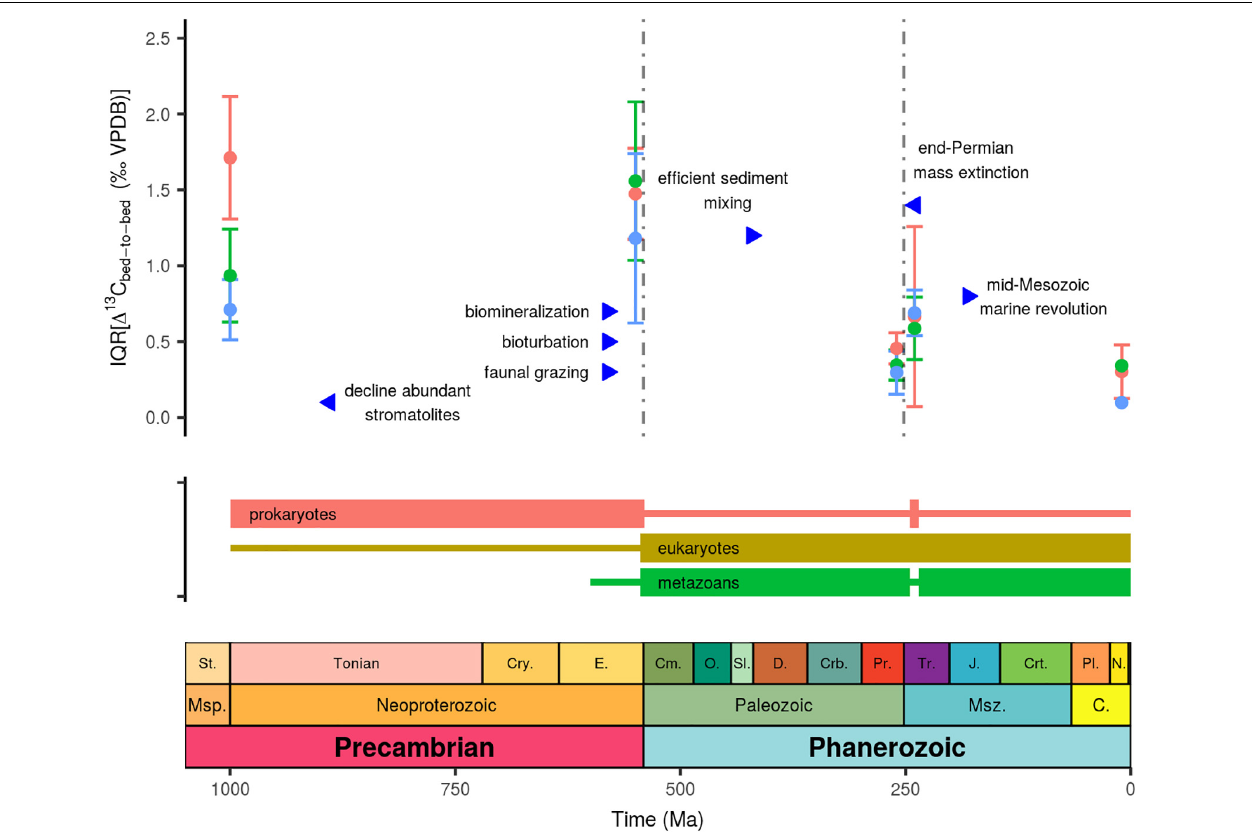
FIGURE 2 | Subsampled (cid:49) 13 C bed − to − bed variation expressed as the interquartile range through time, where blue dots denotes the small bandwidth ( d < 25 cm; or t < 25 ky); green demarcates the intermediate bandwidth (25 < d < 100 cm; or 25 < t < 100 ky), and red marks the large bandwidth ( d > 100 cm; or t > 100 ky). See main text for sources of key biological and ecological